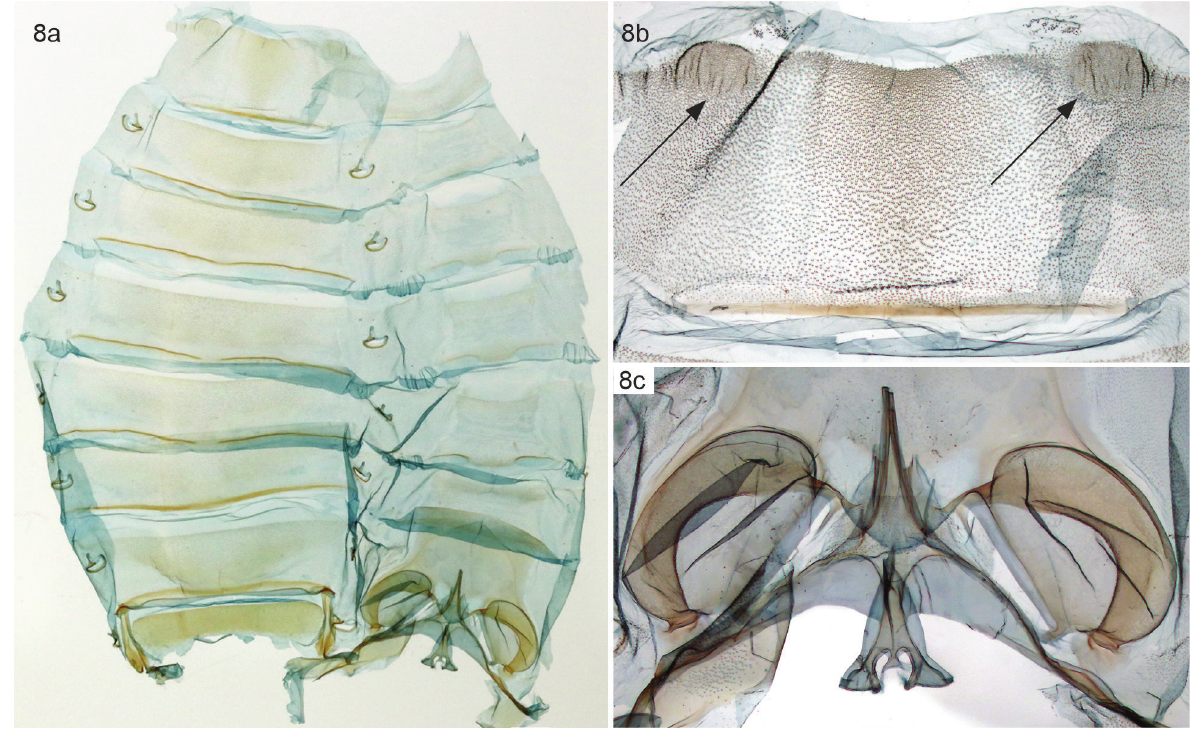
Figure 8. Descaled male abdomen of Sacada chaehomensis sp. nov. (holotype) 8a abdomen 8b 8 th tergite 8c tympanal organs (slide Sihvonen 2828).